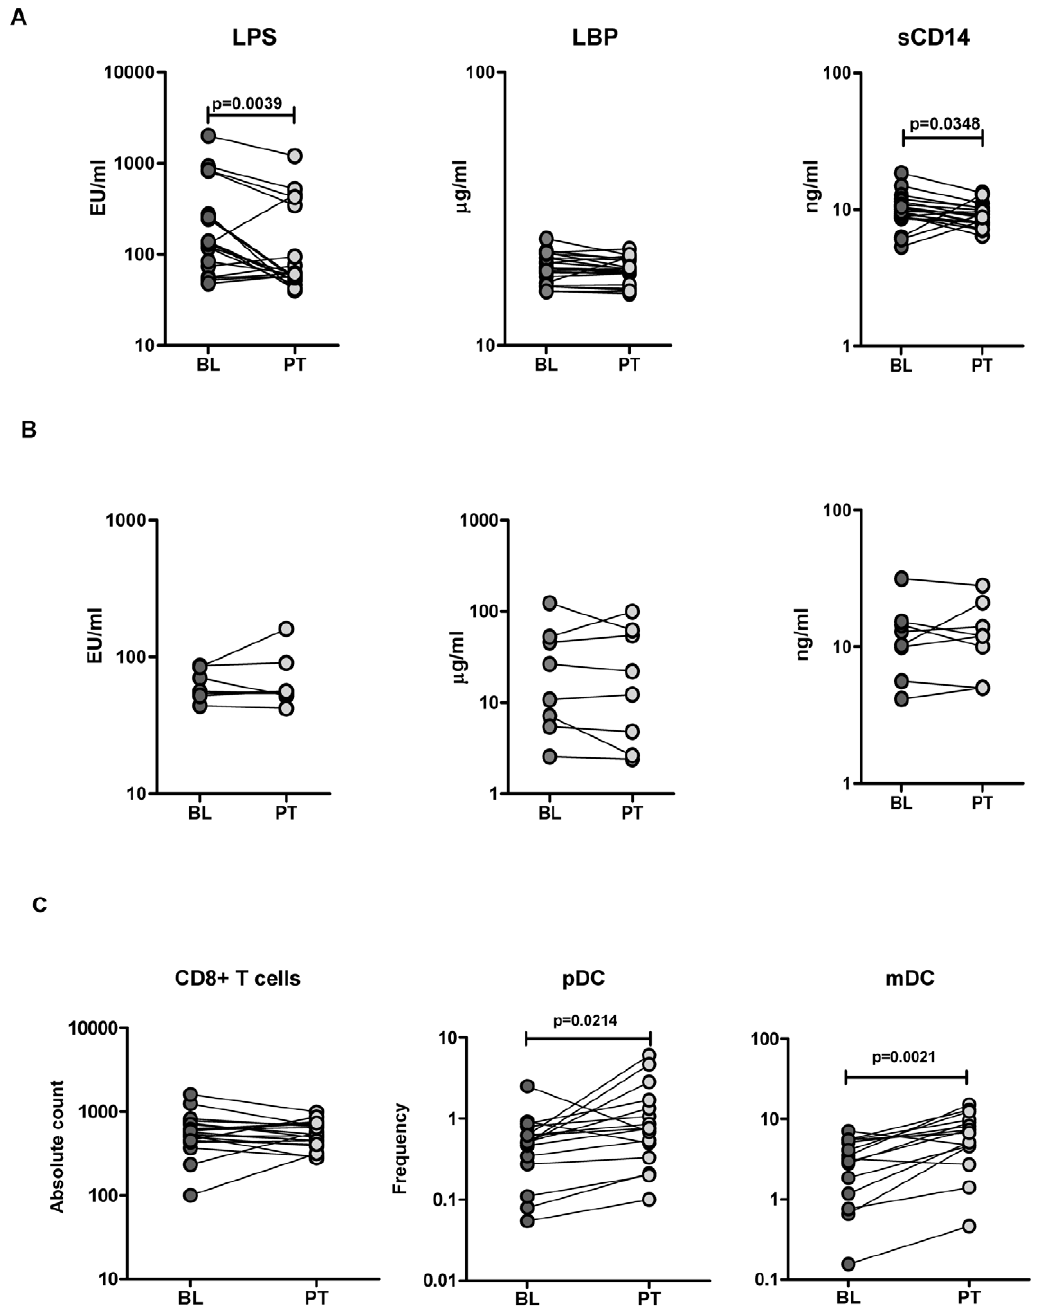
Figure 5. Treatment of hookworm infection is associated with alterations in MTMs and dendritic cell (DC) subsets. A , Plasma levels of lipopolysaccharide (LPS), lipid binding protein (LBP), soluble CD14 (sCD14), and endotoxin core antibody IgG (EndoCAb) from hookworm-infected (n=22) individuals before (BL) and 3 months following treatment (PT) were measured by ELISA. B , Plasma levels of LPS, LBP and sCD14 from hookworm-infected (n=8) individuals, who continued to harbor parasites, before (BL) and 3 months following treatment (PT) were measured by ELISA. C , CD8 + T cell counts and dendritic cell subset frequencies in hookworm infected (n=22) individuals before and 3 months following treatment were measured by flow cytometry. P values were calculated using the Wilcoxon matched pair